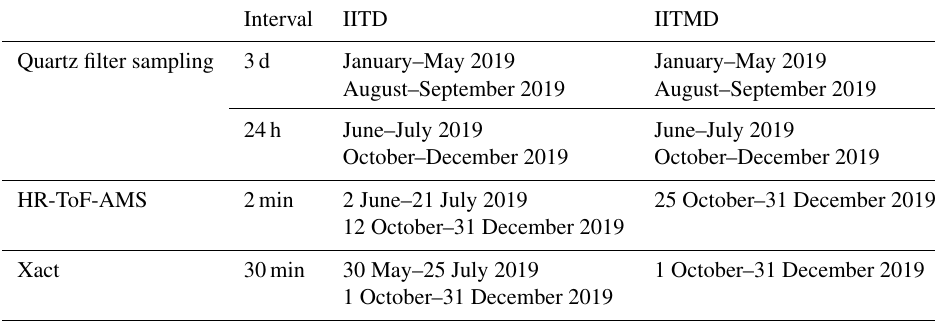
Table 1. Sampling strategy and instrumentation used. Interval IITD IITMD Quartz filter sampling